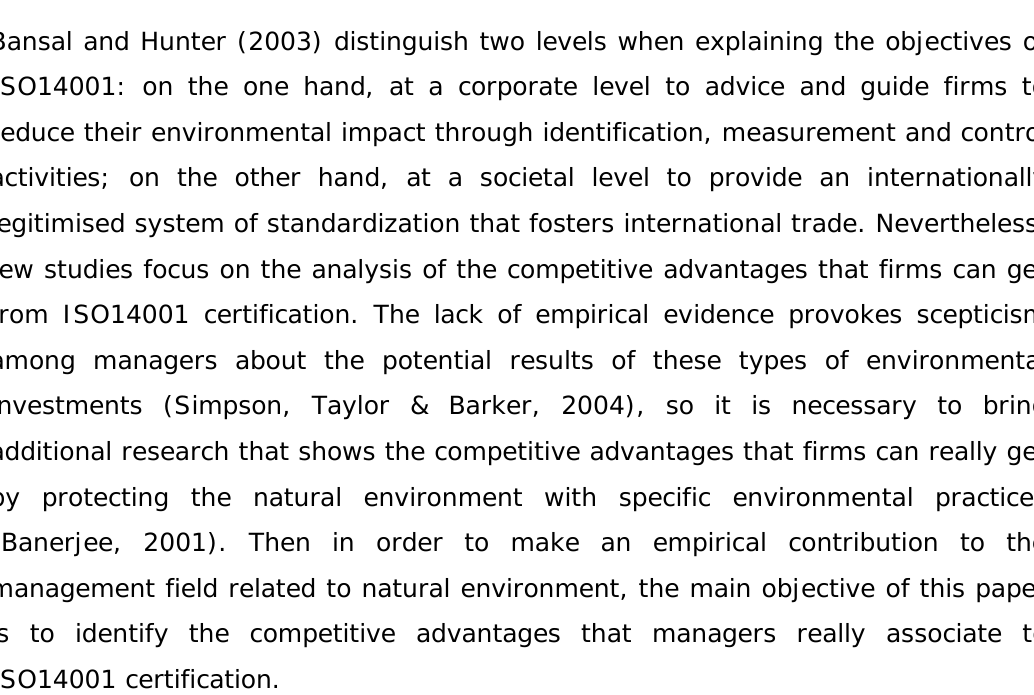
Figure 1. “Implementation process of EMSs based on ISO